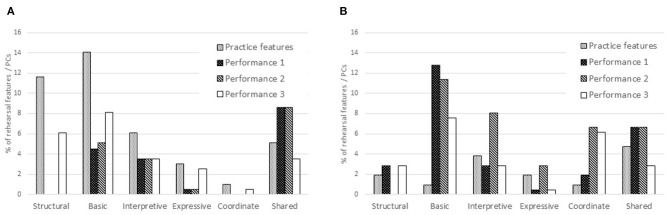
Percentages of rehearsal features that remained or became salient in performances reading from the score: singer (A) and viola player (B).